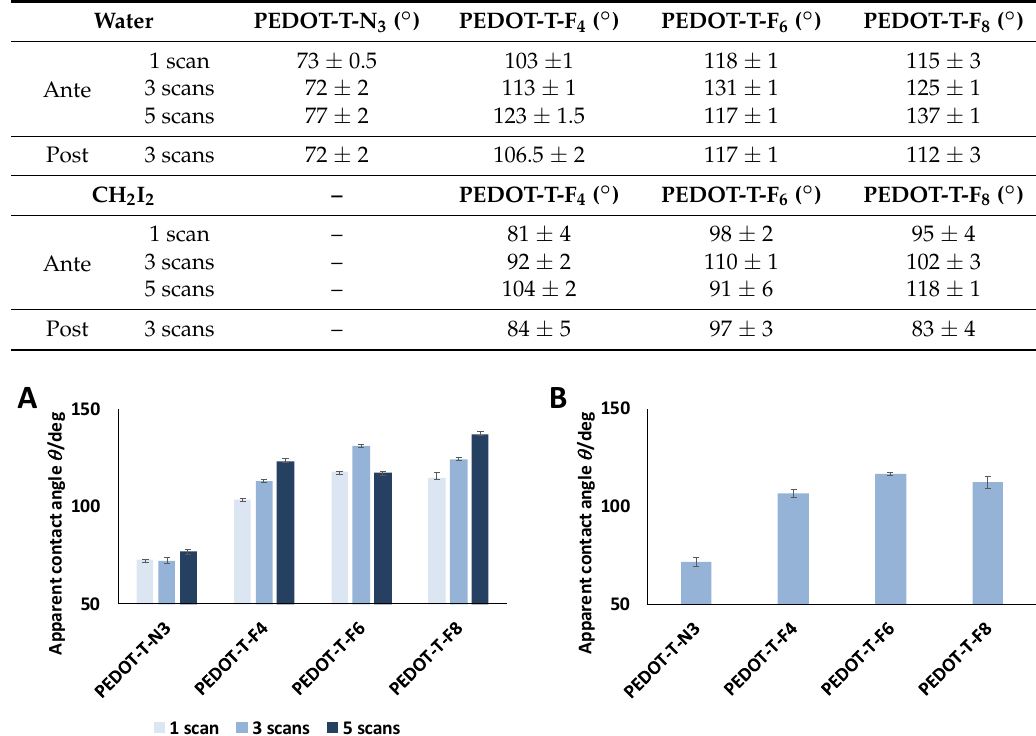
Figure 5. Apparent contact angle with water measured for surfaces developed with ante strategy ( A ) and post strategy ( B ). The bars on the columns illustrate the standard deviations of the measurements.